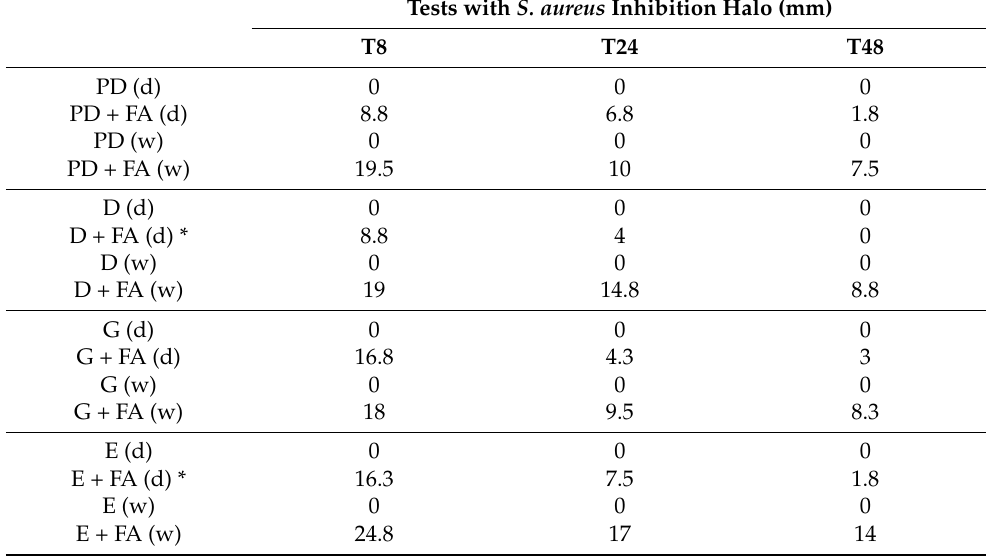
Table 1. Inhibition halos (in mm) for different leather samples (dry (d) or wet (w)) with formic acid (FA) or without formic acid tested against S. aureus . Samples were obtained from the industrial process (pre-dyeing (PD), dyeing (D), greasing (G), and at the end (E)), cooked for 1 h at 60 ◦ C with different contact times (T8, T24, and T48). The measure of the halo (in mm) results from the subtraction of the size of the leather square (20 mm × 20 mm) to the total halo. Tests with S. aureus Inhibition Halo (mm) T8 T24 T48 PD (d) 0